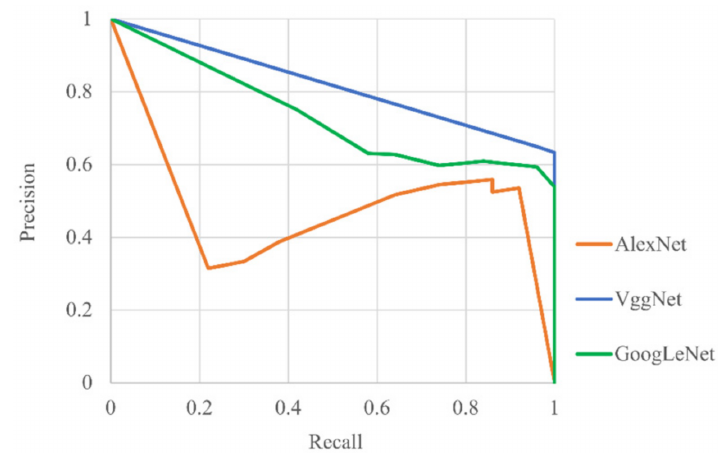
Figure 29. The P-R curve of three CNN models under different viewpoints.